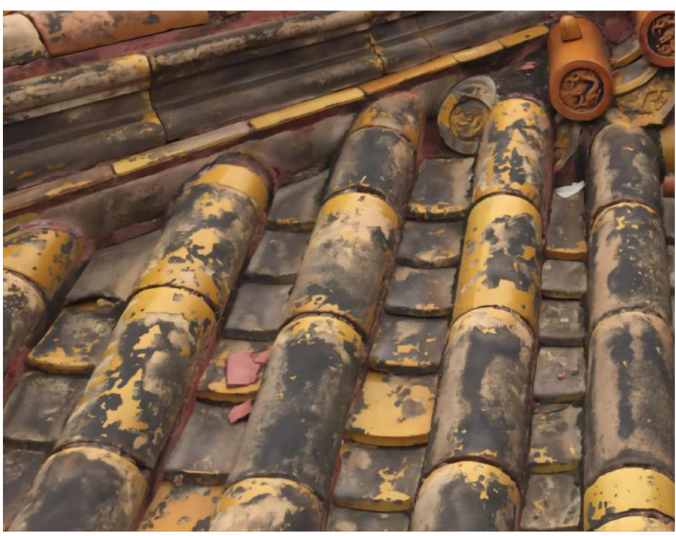
Figure 4. Each cover tile (round shape) is next to two or three under tiles (flat